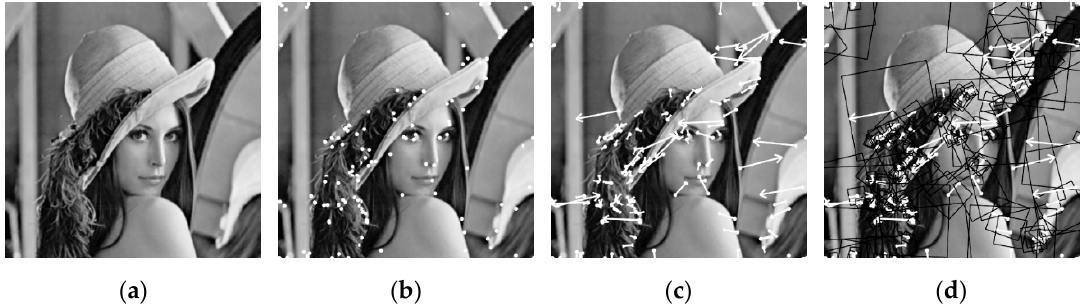
Figure 4. The construction process of local square feature regions in 1024 × 1024 Lena image. ( a ) Luminance image of Lena after a Gaussian function. ( b ) The extracted feature points by modified Harris–Laplace. ( c ) The associated orientation. ( d ) The associated LSFRs.